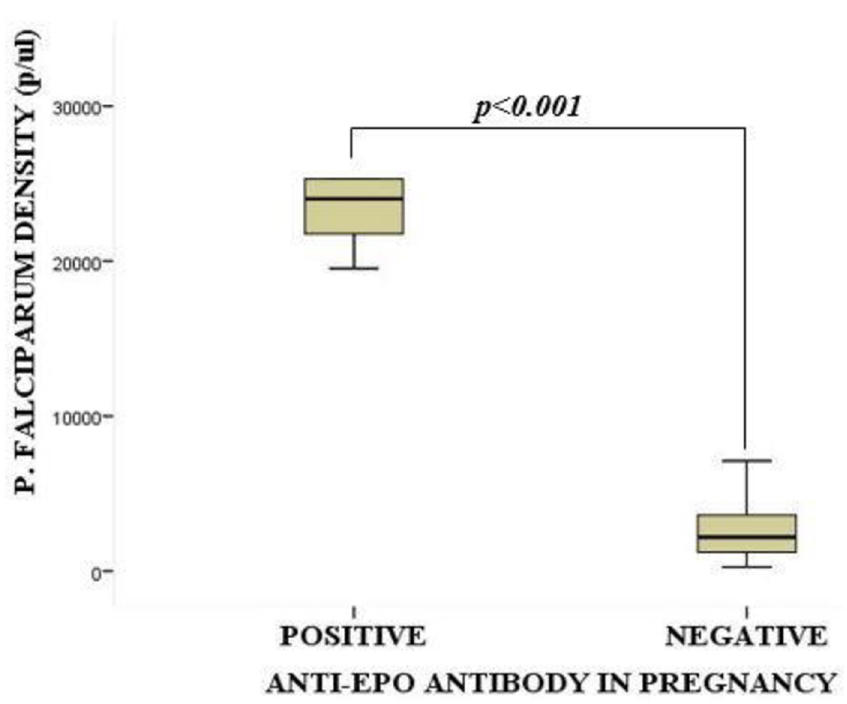
Fig 4. Association between serum anti-erythropoietin antibodies and P . falciparum parasite density among pregnant women. Anti-EPO = Anti-Erythropoietin , p/ μ L = Parasite per Microlitre. Data were compared using Mann Whitney U-Test. p < 0.05 was considered